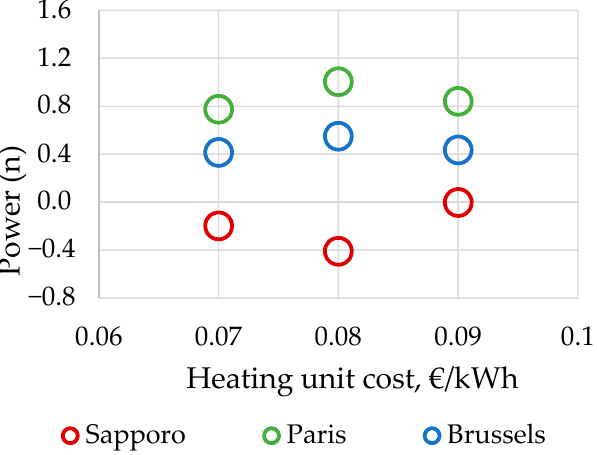
Figure 14. Range of power, which gives no deviation compare to reference climate for cases of the total energy of the whole building model.